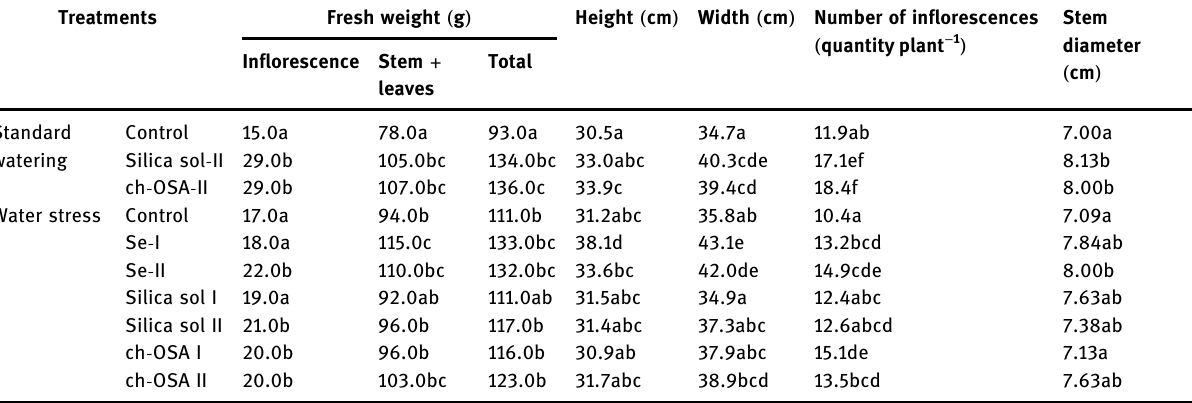
Table 1: The in fl uence of the factors on the biometric parameters of Tagetes patula L. “ Pascal ”